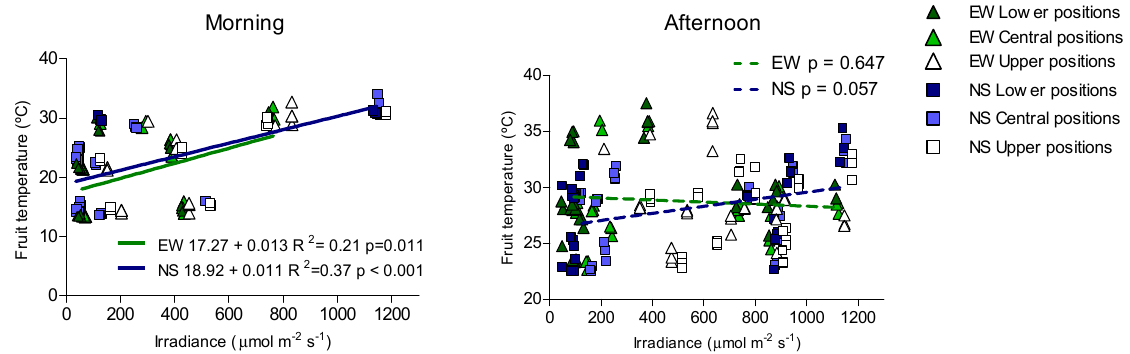
Figure 4. Relationship between fruit temperature measured on fruit located at three heights and corresponding simulated irradiance on both sides of NS and EW hedgerows planted at three row spacings (5.0, 3.75 and 2.5 m). Fruit temperature was measured on two occasions (morning and afternoon, 8 and 15 h solar time) on each of two days during oil synthesis during 2012 and 2013. Solid and dashed lines are significant and no significant regressions, respectively.